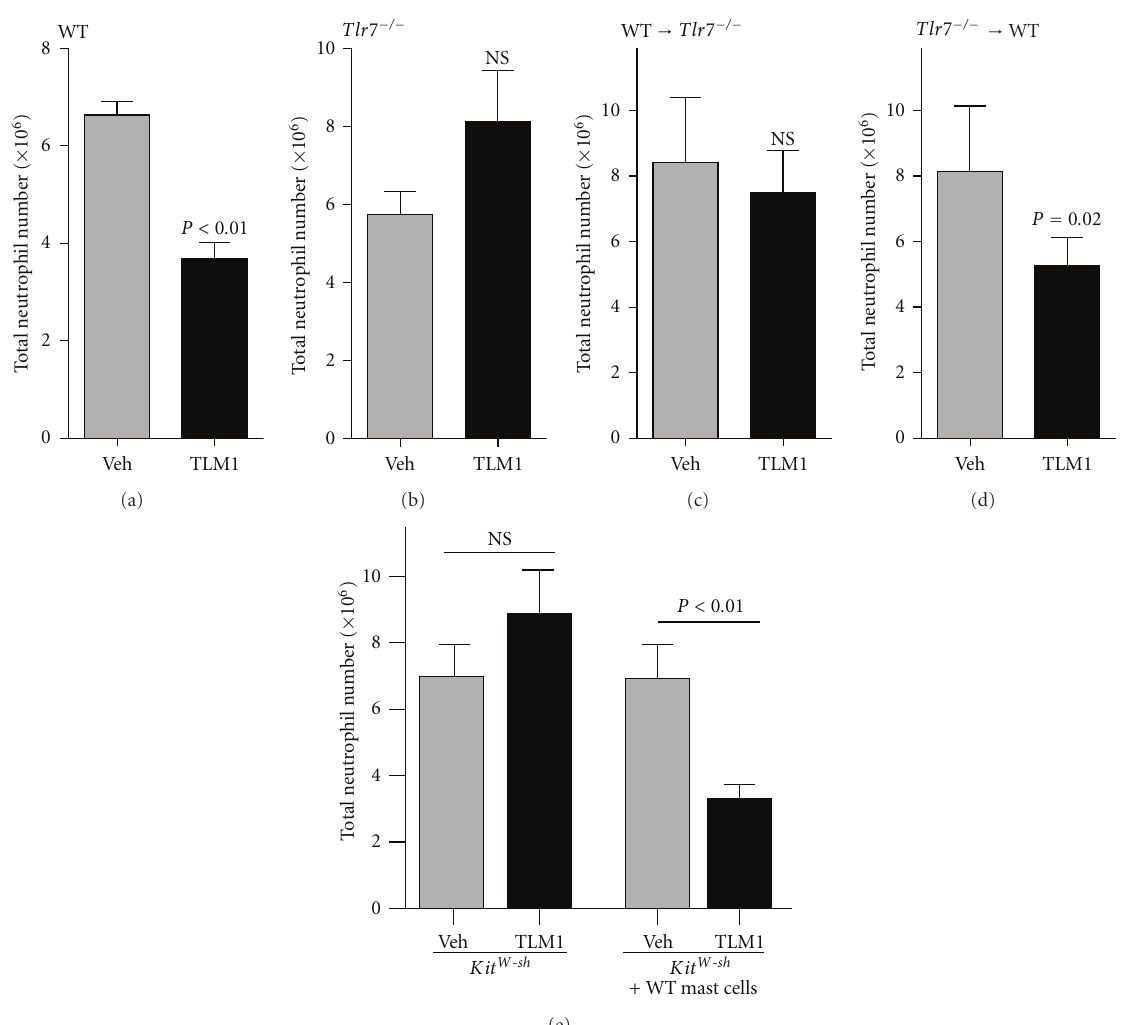
Figure 4: Radioresistant mast cells were involved in suppression of neutrophil recruitment by Tolerimod1 treatment. (a) WT, (b) Tlr 7 − / − , or chimeric mice [WT → Tlr 7 − / − (c), and Tlr 7 − / − → WT (d)] were treated with 200 nmol Tolerimod1 (TLM1) s.c. for 3 days and peritonitis was induced with TG ( n = 4 to 8 per group). (e) Mast cell-deficient Kit W - sh mice or Kit W - sh mice reconstituted with WT mast cells were treated with 200 nmol Tolerimod1 (TLM1) s.c. for 3 days, and peritonitis was induced with i.p. TG. The peritoneal cells were recovered by lavage after 3 hours and quantitated. Data shown are mean ± SEM and are pooled from 2 independent experiments that showed similar trends. P values are from comparisons of vehicle (veh)- and Tolerimod1-treated groups by Mann-Whitney